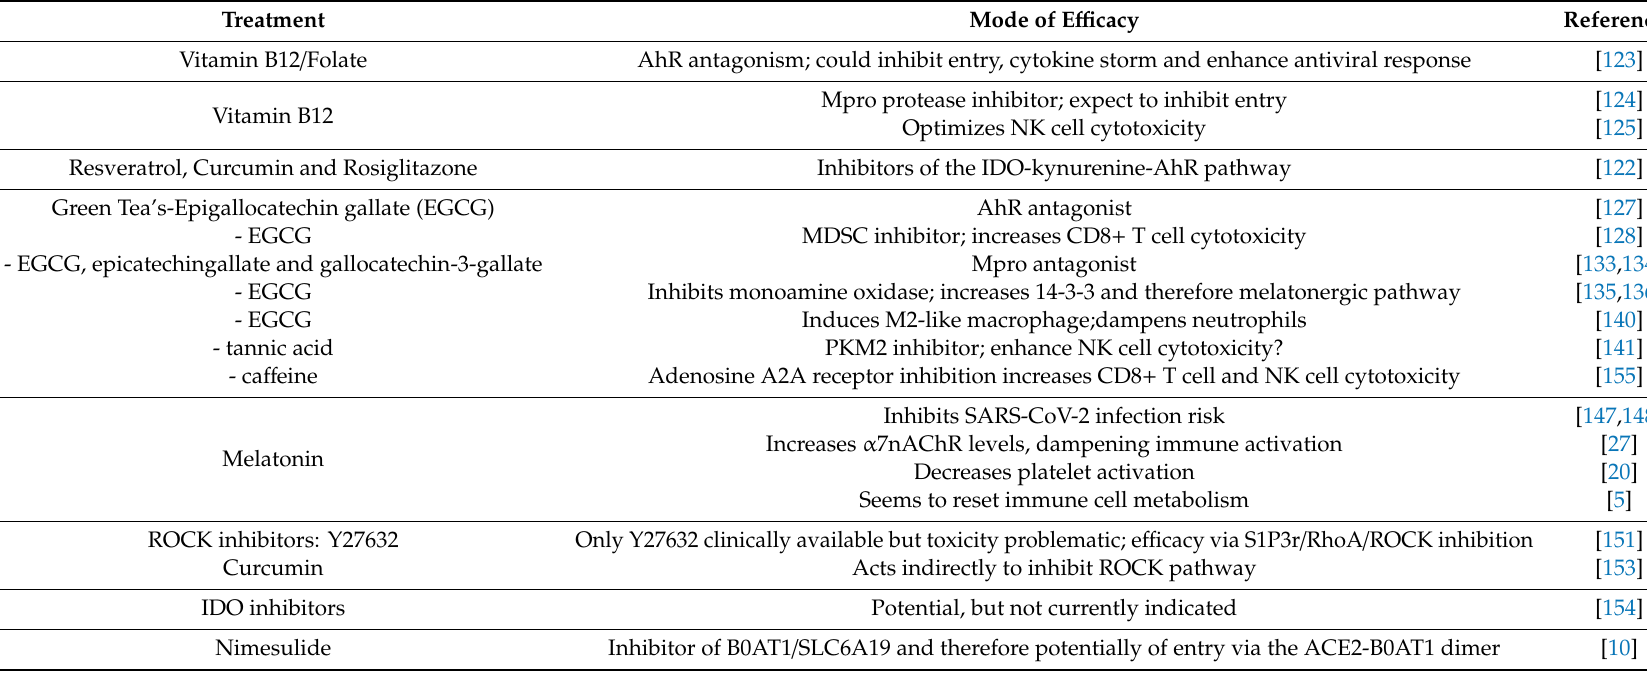
Table 1. Treatment options based on AhR antagonism and current knowledge of SARS-CoV-2